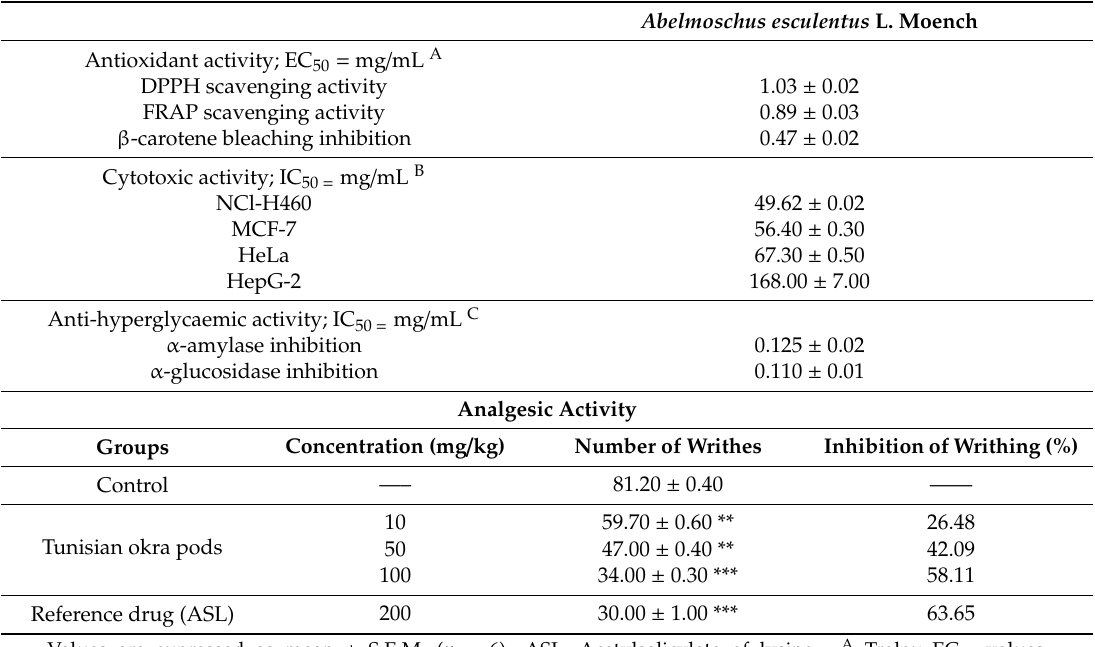
Table 5. Bioactivity of Tunisian okra pods ( Abelmochus esculentus L. Moench). Abelmoschus esculentus L.